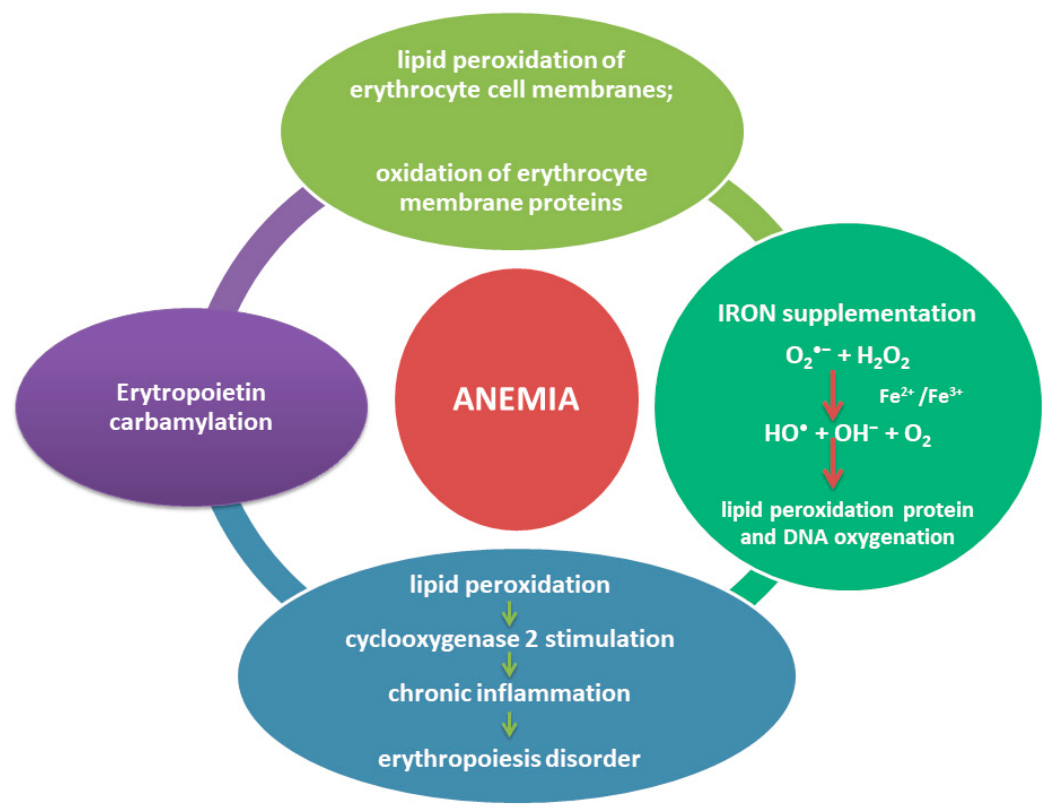
Figure 5. Anemia and oxidative stress in the course of chronic kidney disease.